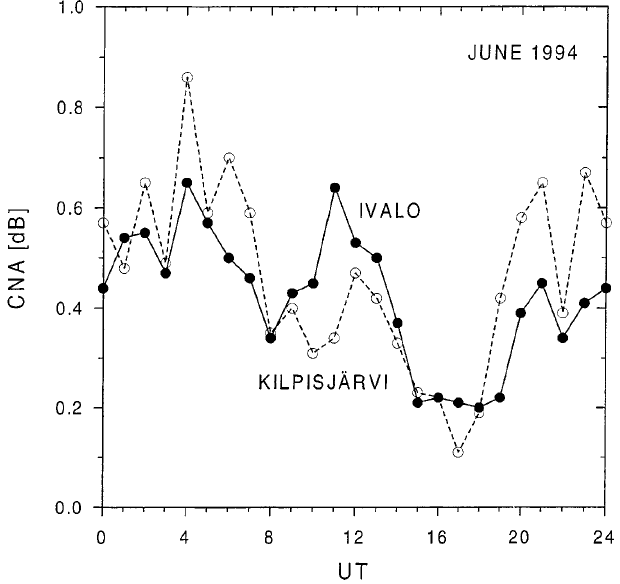
Fig. 6. Mean diurnal variation of CNA at Ivalo ( solid curve ) and Kilpisja¨ rvi ( dashed curve ) during June